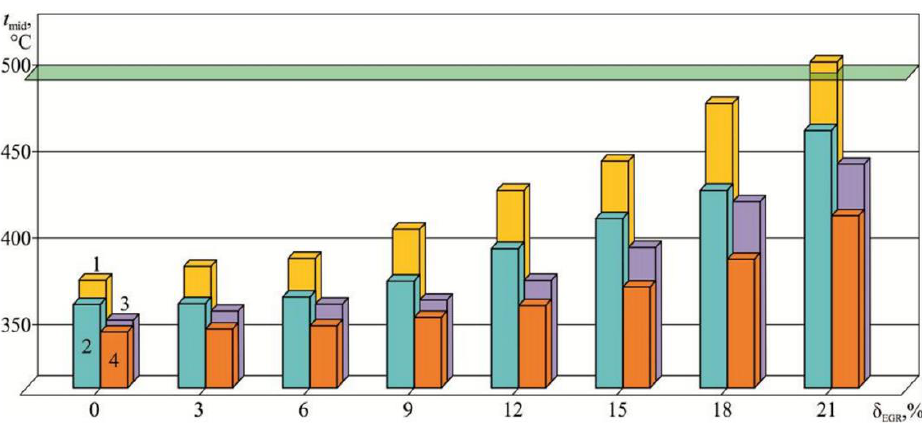
Figure 15. Change in the average exhaust gas temperature t , °С marine diesel 16V32 STX -MAN depending on the degree of recirculation δ EGR : 1 — load 35%; 2 — load 55%; 3 — load 75%; 4 — load 95%.